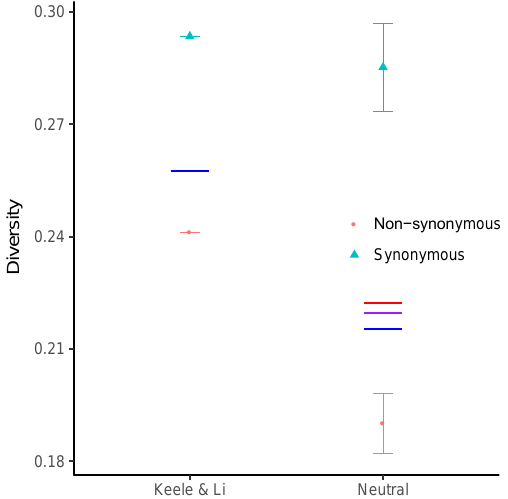
Figure 5. Nucleotide diversity of private non-synonymous and synonymous mutations in the Keele and Li data compared to our neutral model. The blue lines indicate the mean diversity of all private mutations. The purple line indicates the diversity of the neutral model if we adjust the proportion of synonymous mutations to that observed in the Keele and Li data. The red line shows the mean